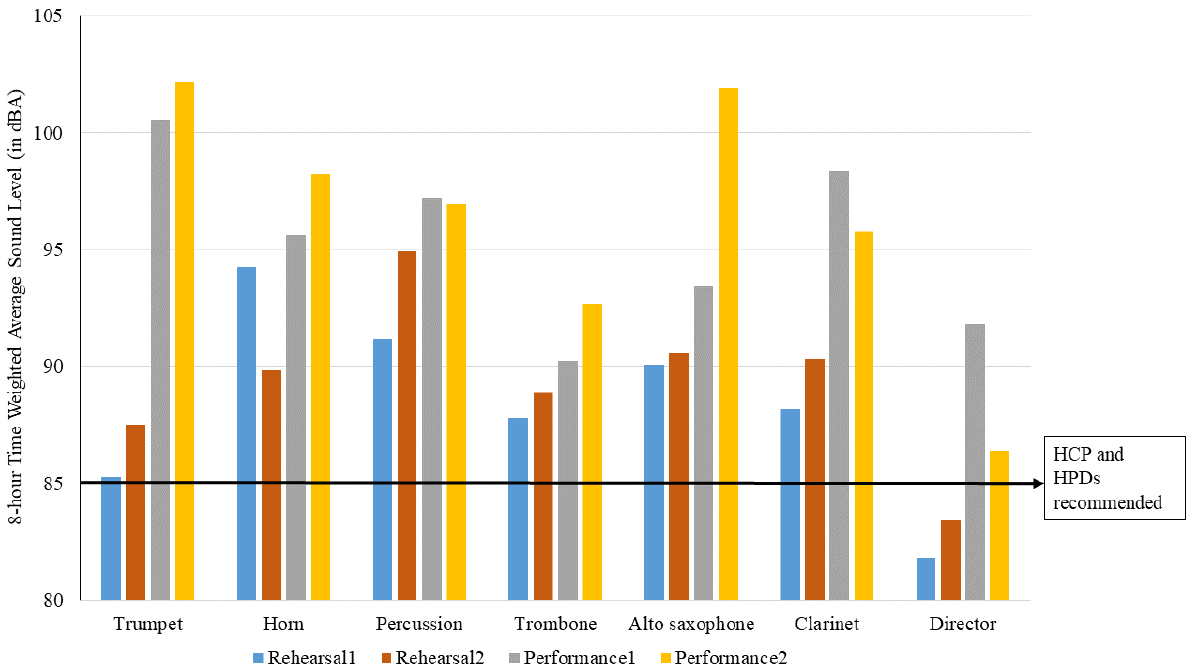
Table 2.. Summarized data for noise dose, L Aeq range, and L TWA(8) of 6 marching band members, director and non-marching band students during performances.